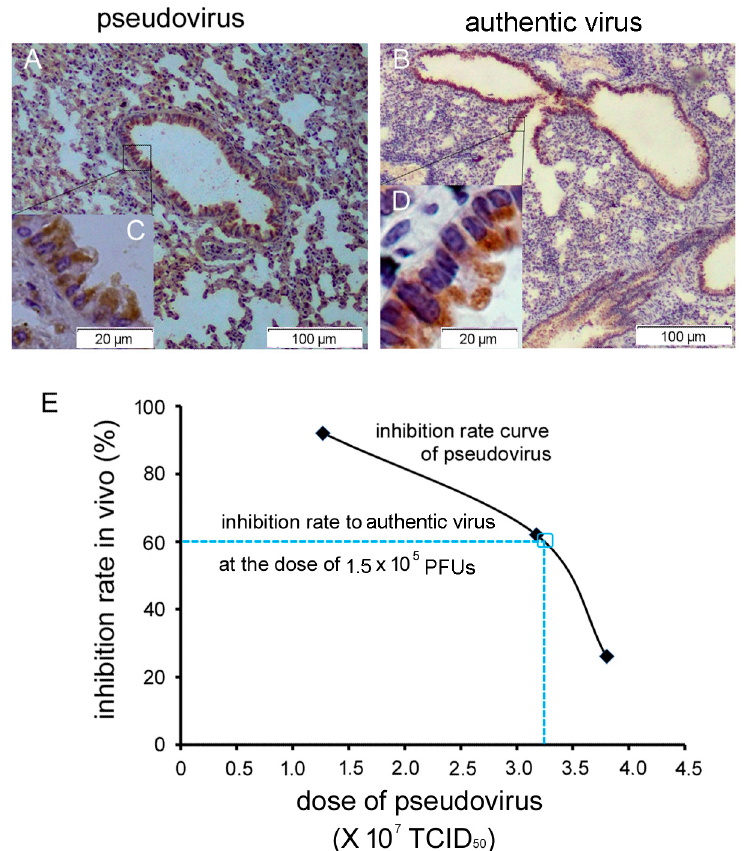
Figure 5. Relationship between pseudovirus and authentic virus models. ( A – D ) Pseudovirus and authentic virus infection in the lungs of R26-hDPP4 mice showed a similar pattern, as shown by IHC using mAb R723 against the RBD of the MERS-CoV S protein. ( C , D ) Both pseudovirus and authentic virus infected ciliated columnar epithelium of bronchi. ( E ) Dose conversion of pseudovirus and authentic virus. The full black line represented the inhibition rate ( (cid:117) ) of humanized mAb H111-1 (1 mg/kg) in vivo using different pseudovirus doses. The blue dashed line represents inhibition rate of H111-1 against authentic virus. When the dose of authentic virus was 1.5 × 10 5 PFUs, we calculated that the inhibition rate of H111-1 at a dose of 1 mg/kg would be 60% (see main text). From the inhibition rate curve of pseudovirus, the corresponding pseudovirus dose was 3.25 × 10 7 TCID 50 . That is, 1 TCID 50 of pseudovirus corresponded to 0.0046 PFU of authentic virus (1.5 × 10 5 /3.25 × 10 7 ). n = 4–6 mice per group.